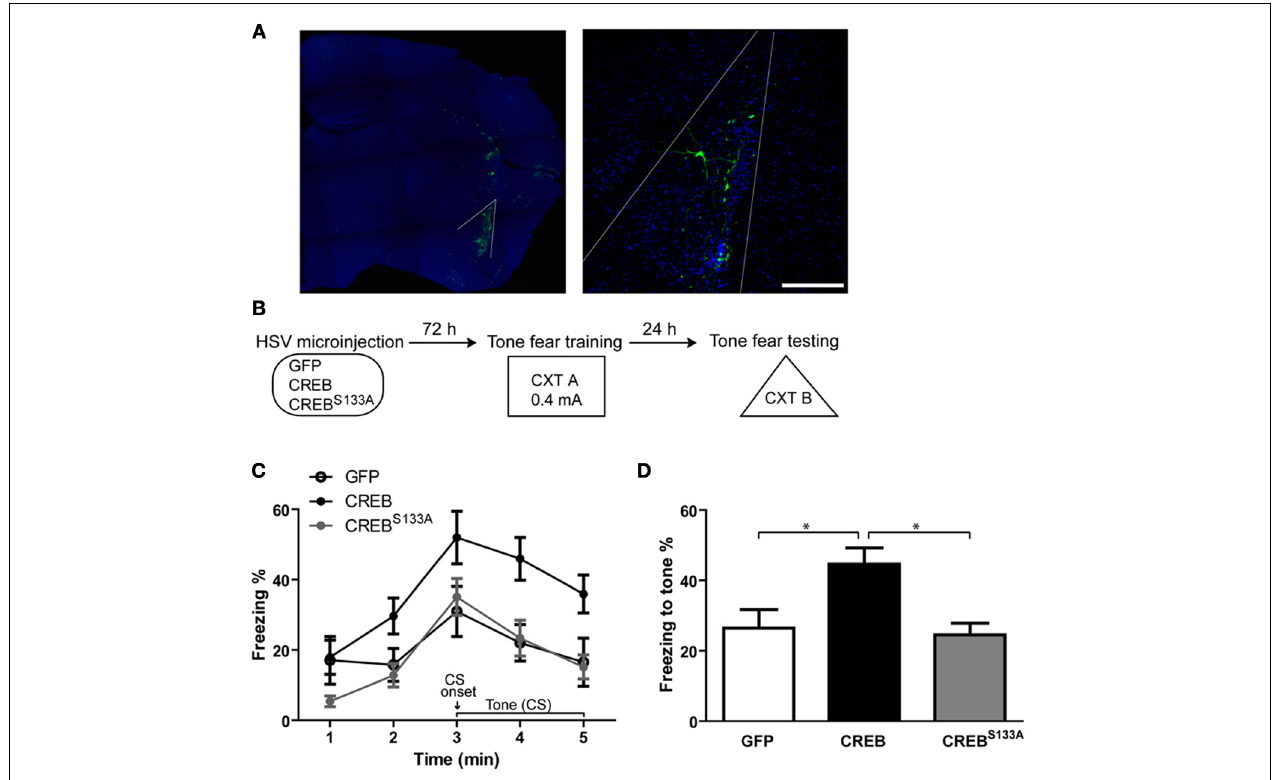
FIGURE 1 | Overexpressing CREB in LA neurons enhances, while dominant negative CREB S133A does not affect, auditory fear memory. (A) Visualizing neurons infected with viral vectors. Left: Outline of the LA. Maximumintensityprojectionisshown.Right:LAprincipalneuronsexpressing GFP 72h following viral vector microinjection (nuclei stained with DAPI, infected neurons visualized with anti-GFP antibody). 0.25 μ m optical section is shown. Scale bar, 100 μ m. (B) Experimental design. Auditory (tone) fear conditioningwasconducted72hafterHSVmicroinjection.Micewereplacedin